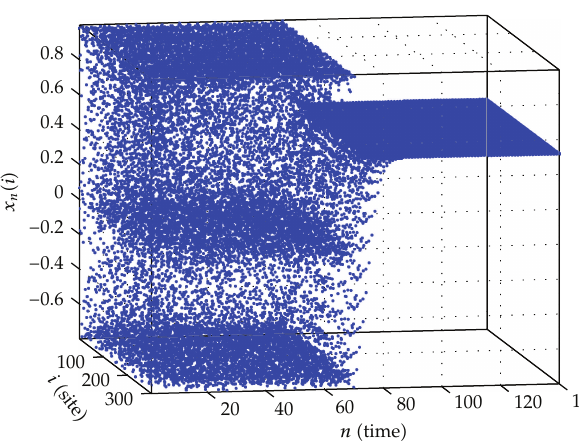
Figure 6: The control result of the DCML (cid:3) 3.18 (cid:4) , with the parameter values a (cid:8) 1 . 8, (cid:2) (cid:8) 0 . 01, and α 1 (cid:8) 0 . 85. The feedback control starts at the 71st